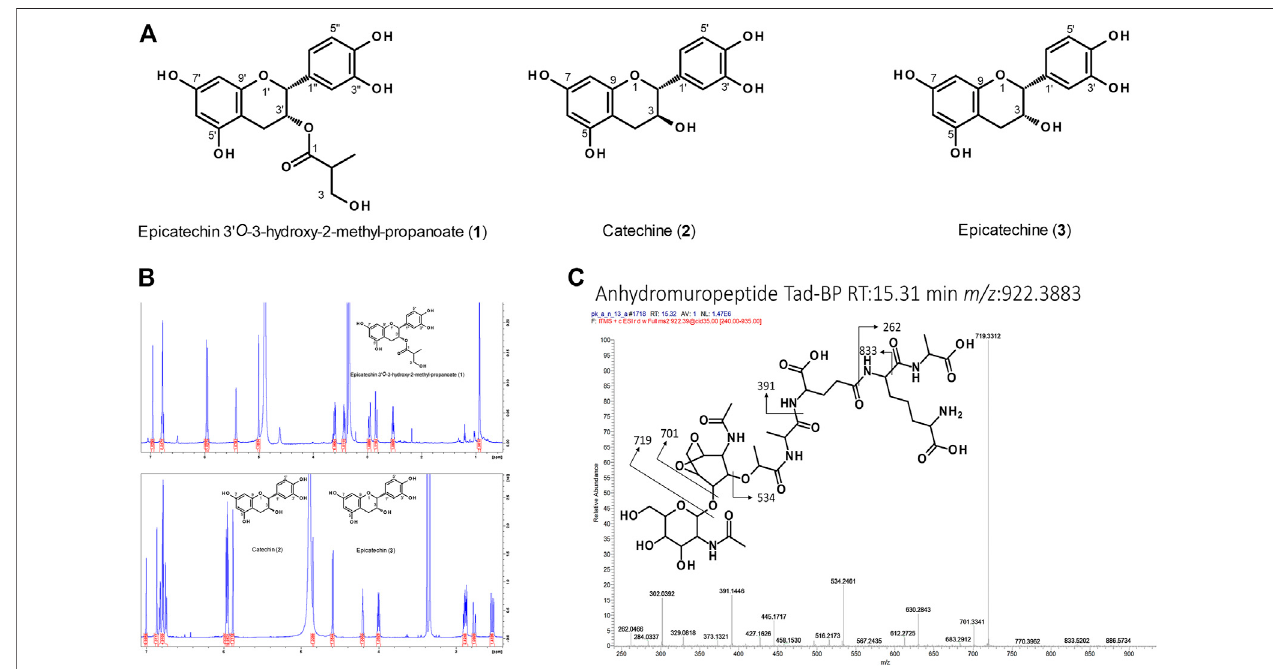
FIGURE 6 | (A) Structures of fl avan-3-ol derivatives isolated from nodulated Ardisia crenata leaf tissues. (B) NMR analysis of these fl avan-3-ol derivatives. (C) Annotated ESI-MS2 spectrum (pos. mode, CID fragmentation) of anhydromuropeptide with a precursor m/z 922.39 in LC-MS analyses of Psychotria punctata leaf nodule